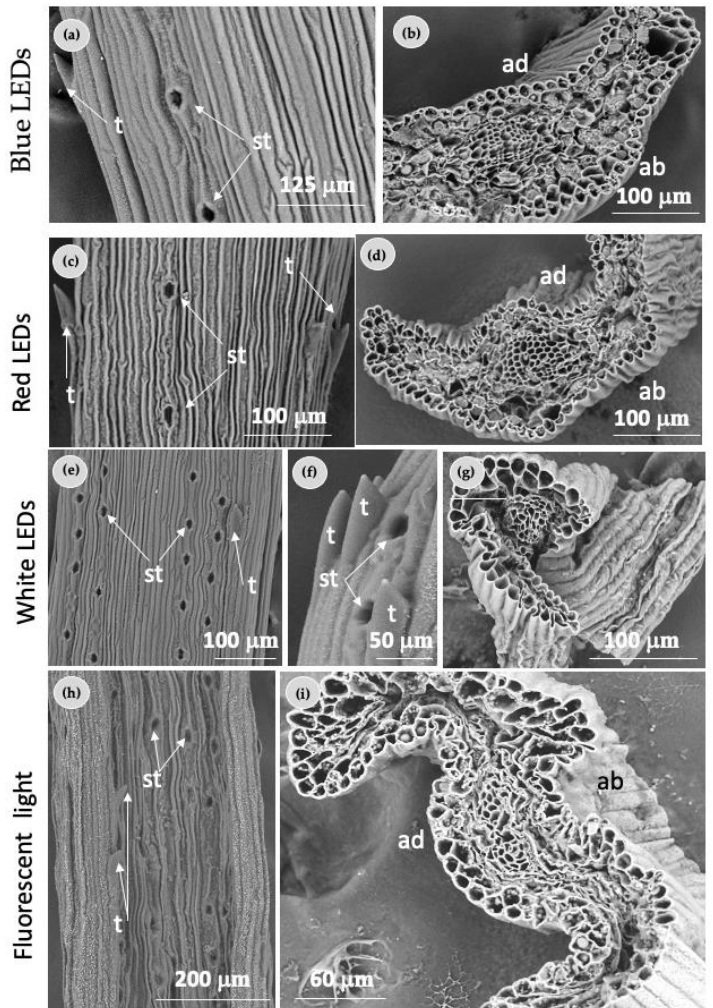
Figure 5. Scanning electron microscopy observations of needles from in vitro Pinus ponderosa plantlets exposed to different light treatments: ( a ) adaxial surface of a needle showing teeth (t) and two rows of stomata (st); ( b ) needle cross section; ( c ) adaxial surface of a needle showing teeth (t) and two rows of stomata (st); ( d ) needle cross section; ( e ) adaxial surface of a needle showing teeth (t) and two rows of stomata; ( f ) close view of the stomata. A tooth can also be observed; ( g ) needle cross section; ( h ) adaxial surface of a needle showing teeth (t) and two rows of stomata (st); ( i ) needle cross section. ab—abaxial surface; ad—adaxial